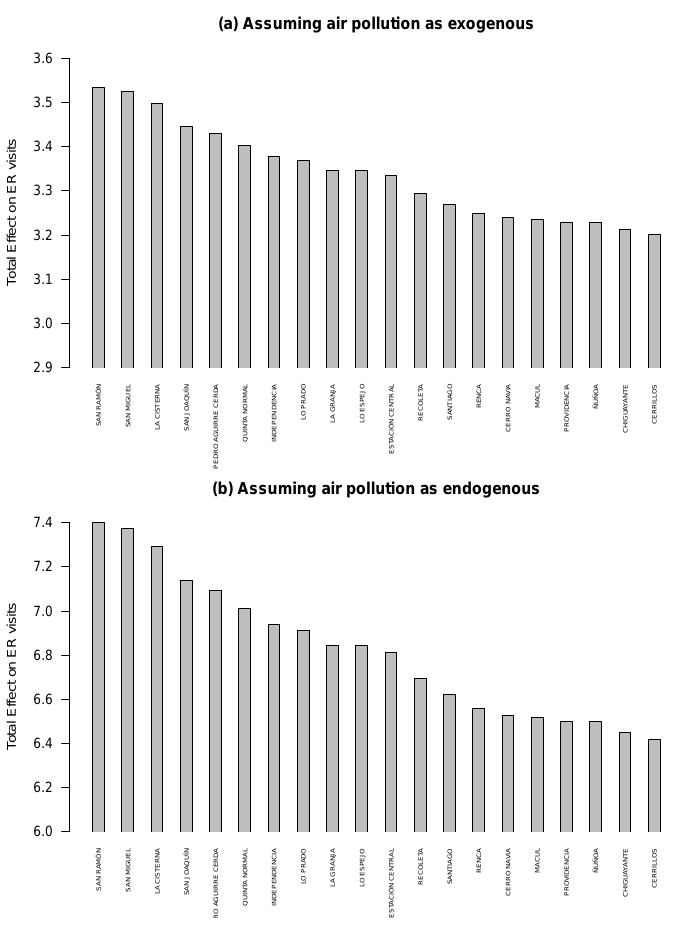
Figure 5: Municipalities that generates the higher total